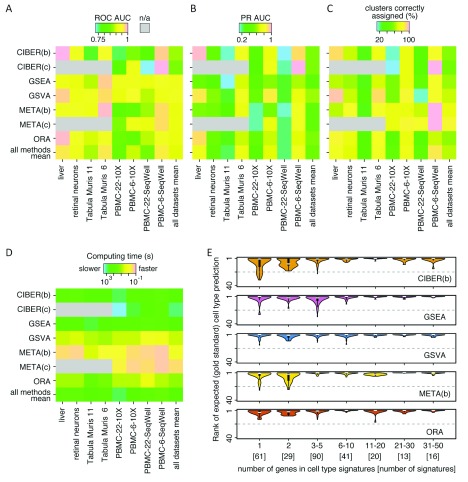
Summary of performance and computing time of cell type prediction methods using scRNA-seq data.(
A) A heatmap showing a summary of cell type prediction ROC AUCs for the five datasets used (x-axis), including two variants each of the Tabula Muris and PBMC datasets, for the five methods studied (y-axis), including two approaches for CIBERSORT (‘binary’ CIBER(b), and ‘continuous’ CIBER(c)) and METANEIGHBOR (‘binary’ META(b), and ‘continuous’ META(c)). The mean ROC AUCs for each method across all scRNA-seq datasets and for each dataset across all methods are provided. (
B) A heatmap similar to (
A), but showing PR AUC values. (
C) A heatmap showing the percentage of clusters correctly assigned by each method for each dataset. (
D) A heatmap showing computing times for each cell type prediction task and the mean across all scRNA-seq datasets. Actual values for panels
A to
D are provided in Supplementary Table 1. (
E) Violin plots showing the influence of the number of genes in cell type signatures on methods that use gene sets as inputs. The number of genes in the signatures is shown on the x-axis along the number of signatures with that number of genes, in brackets. The rank of the expected (gold standard) predictions is shown on the y-axes. A perfect method would show its gold standard predictions ranked as ‘1’.